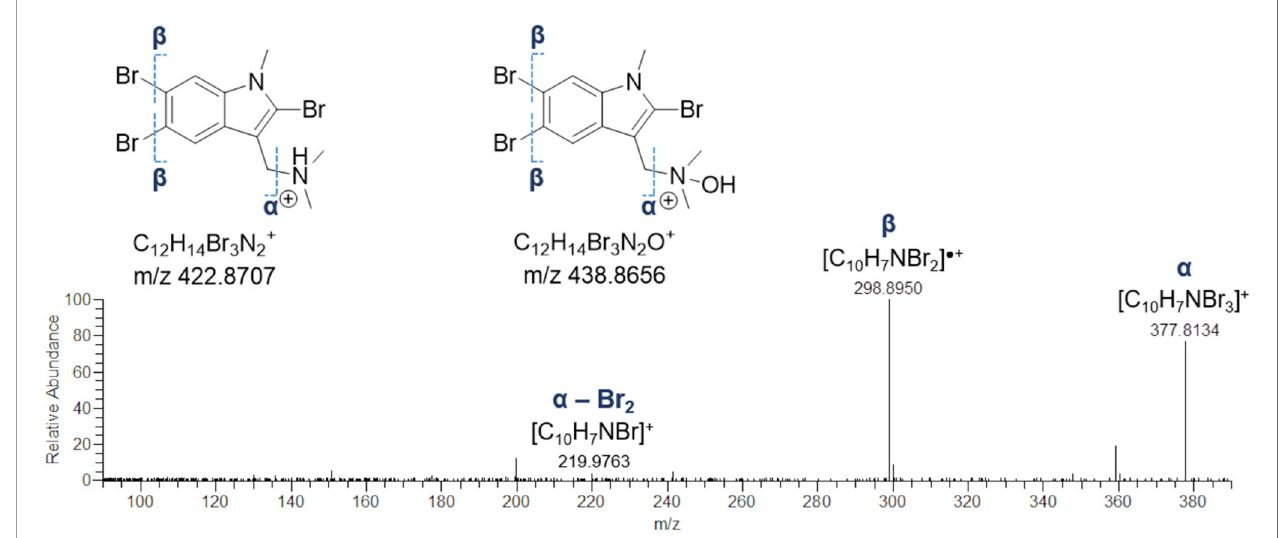
FIGURE 9 | HR ESI-MS 2 spectrum of the fragment ion at m/z 377.8134, generated by neutral loss of dimethylamine and dimethylhydroxylamine from 2,5,6- tribromo-1-methylgramine and 2,5,6-tribromo-1-methylgramine N -oxide,